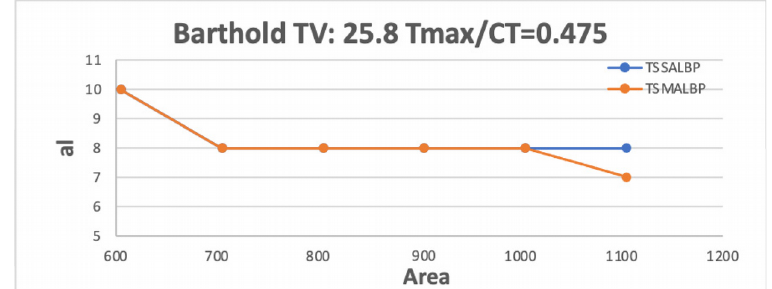
Figure 8. The number of stations drawn against the area for Barthold instance with low TV and moderate T